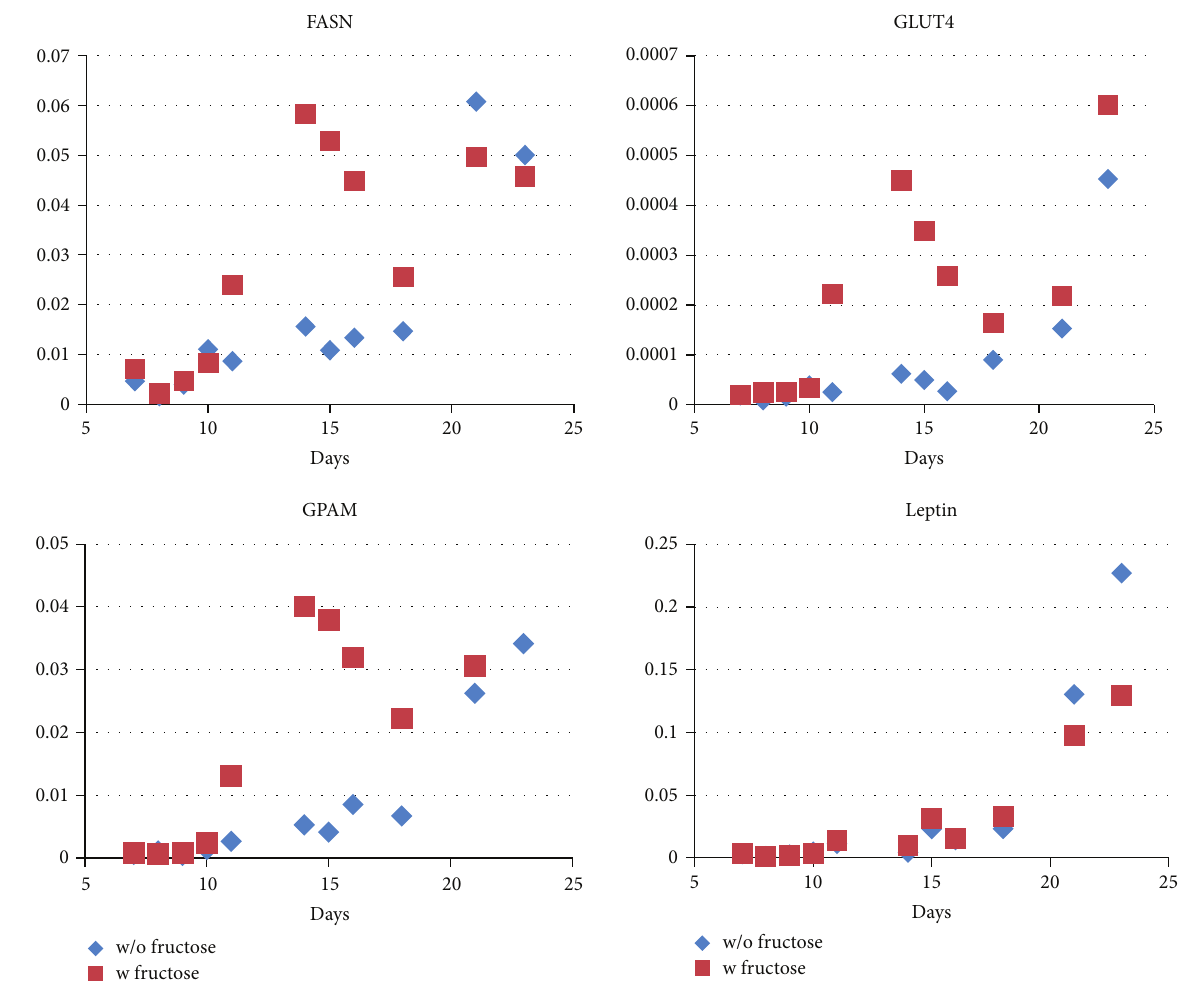
Figure 1: Fructose transiently induces genes involved in lipogenesis during adipocyte maturation. Expression of important lipogenic genes is shown in the presence (red squares) and in the absence of fructose (blue diamonds). 𝑦 -axis: relative expression compared to expression of actin mRNA. FASN and GPAM are strongly induced between day ten and sixteen. The insulin-dependent glucose transporter GLUT4 follows the same course. No significant differences are seen for leptin expression. Each symbol depicts one qPCR measurement per dish in a representative